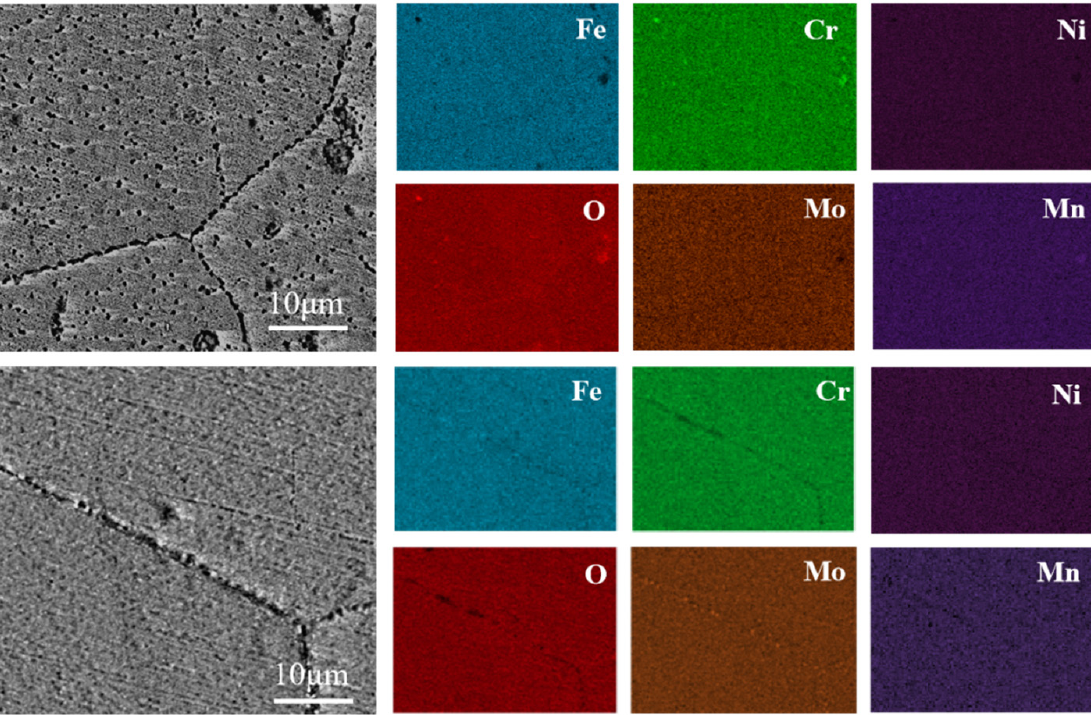
Figure 3. The SEM surface morphologies and EDS analysis results of the 254SMO–0B ( a ) and 254SMO–40B ( b ) samples after oxidation at 900 °C for 30min. Figure 4 shows the surface morphologies of the 254SMO–0B and 254SMO–40B sam ‐ ples after oxidation at 1000 °C for 1.5min and 3min, respectively. As can be seen from the figure, the oxidation degree of the two samples at 1000 °C is higher than that at 900 °C, and the oxidation degree of 254SMO–0B sample is higher than that of the 254SMO–40B sample. The surface oxidation degree of the 254SMO–0B sample at 1000 °C for 3min is higher than that at 900 °C for 30min, which indicates that temperature has a greater influ ‐ ence on the surface oxidation process of the sample. The oxidation degree of the 254SMO– 40B sample at 1000 °C for 3min is similar to that at 900 °C for 30min, and the oxide layers